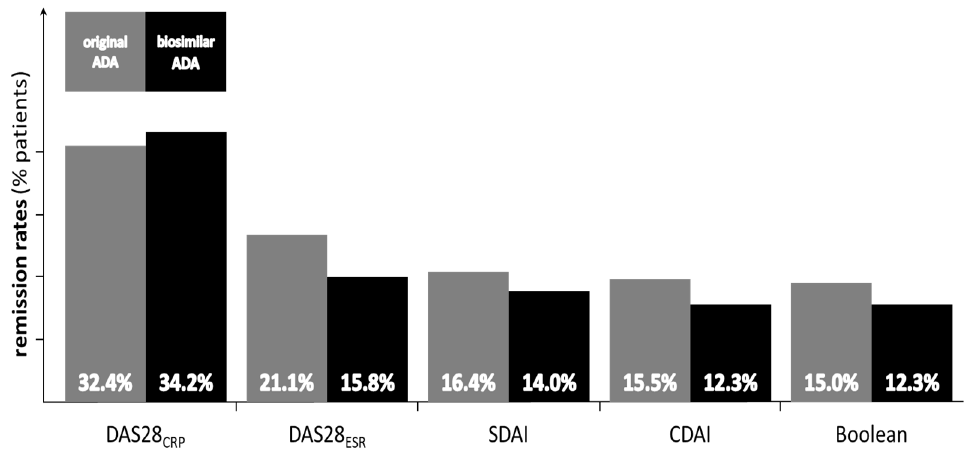
Figure 1. The 6-month remission rates of the 213 patients on original adalimumab and 228 on biosimilar adalimumab, according to the following definitions: DAS28CRP ( p = 0.727), DAS28ESR ( p =